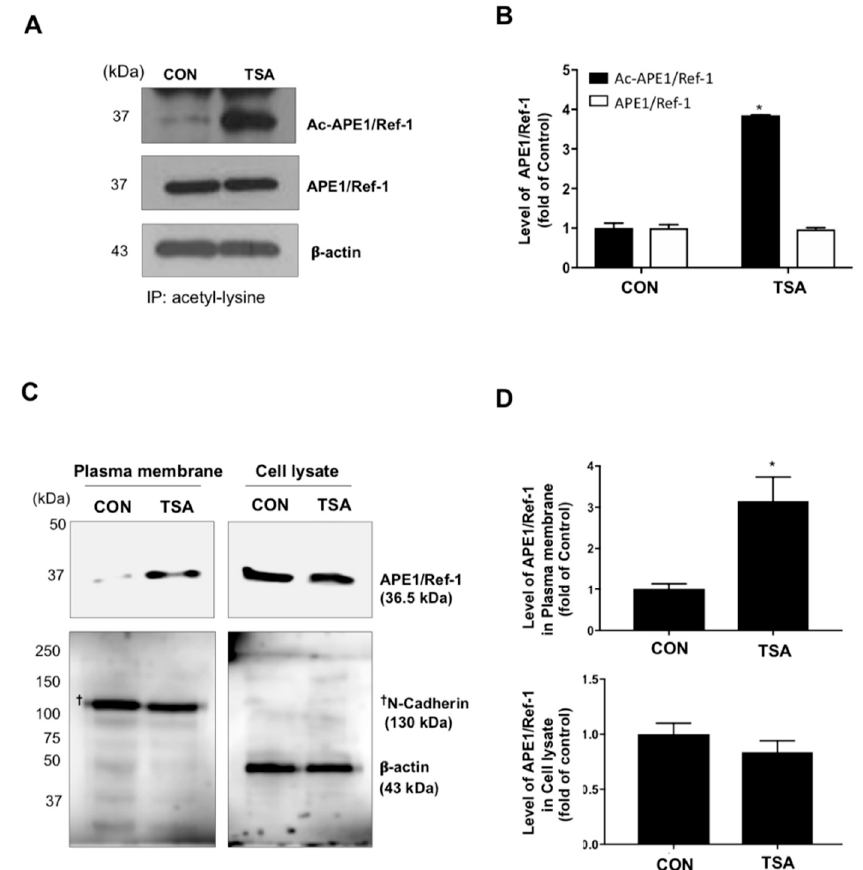
Figure 5. Intracellular APE1 / Ref-1 was targeted to the plasma membrane in response to acetylation. ( A , B ) Whole cell lysates were immunoprecipitated using an anti-acetyl lysine antibody, followed by immunoblotting with the polyclonal anti-APE1 / Ref-1 antibody. The blots were stripped and re-probed with anti- β -actin and APE1 / Ref-1 antibody to ensure equal protein loading. Similar results were obtained from replicate experiments. Column, mean ( n = 3); bars , SE. *, p < 0.05, significantly di ff erent compared with control or between group by one-way ANOVA followed by Bonferroni’s multiple comparison test. ( C , D ) Membrane fractions or whole cell lysates were prepared from the TSA-treated cells. Immunoblotting for APE1 / Ref-1 was performed using the polyclonal anti-APE1 / Ref-1 antibody. Blots were stripped and re-probed with anti-N-cadherin and anti- β -actin antibodies to control for di ff erences in protein loading. Fold changes in the levels of APE1 / Ref-1 in the plasma membrane fraction relative to the control are shown. † , indicates molecular marker (N-cadherin) of left image. Column mean ( n = 3); bars , SE.*, p < 0.05 indicates a significantly di ff erent result compared with control or between groups by one-way ANOVA followed by Bonferroni’s multiple comparison